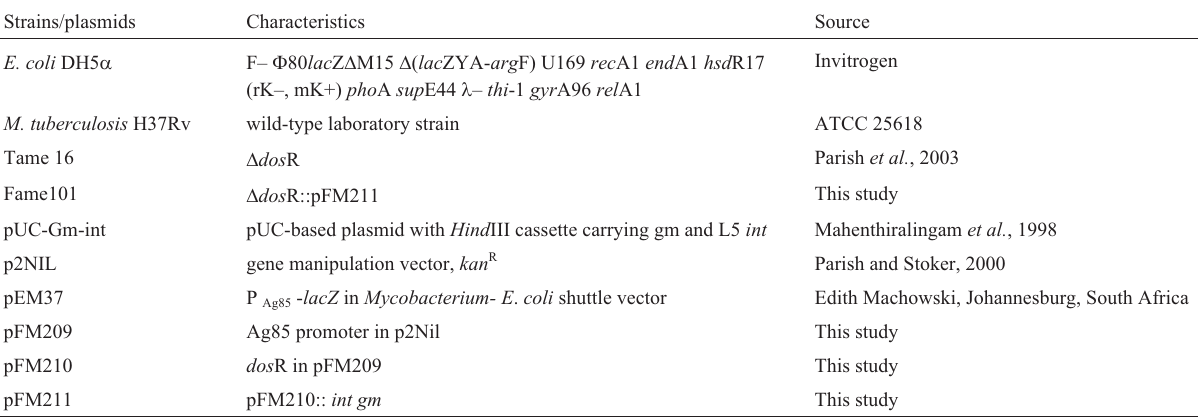
Table 1 - Strains and plasmids used in this